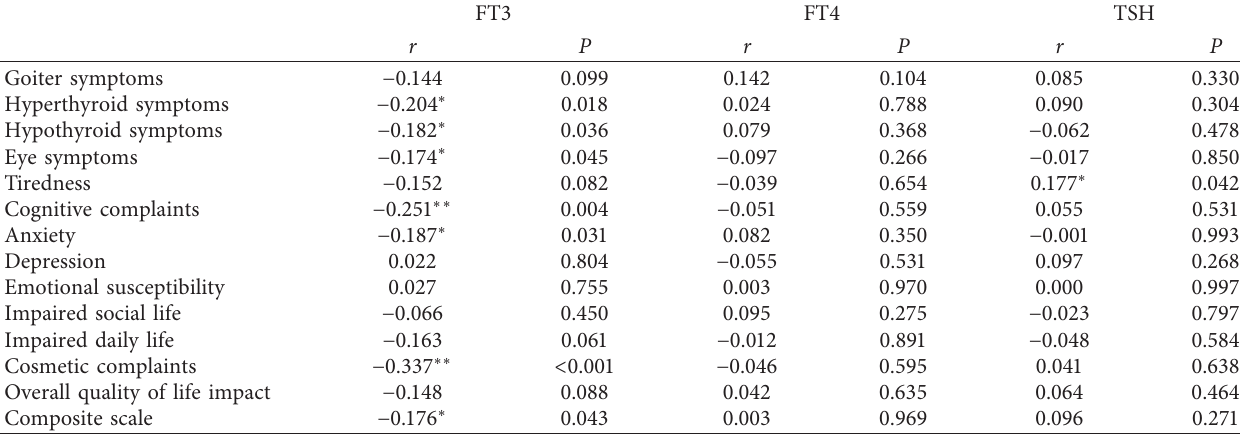
Table 2: Correlations of FT3, FT4, TSH, and ThyPRO scores in all patients with HT.